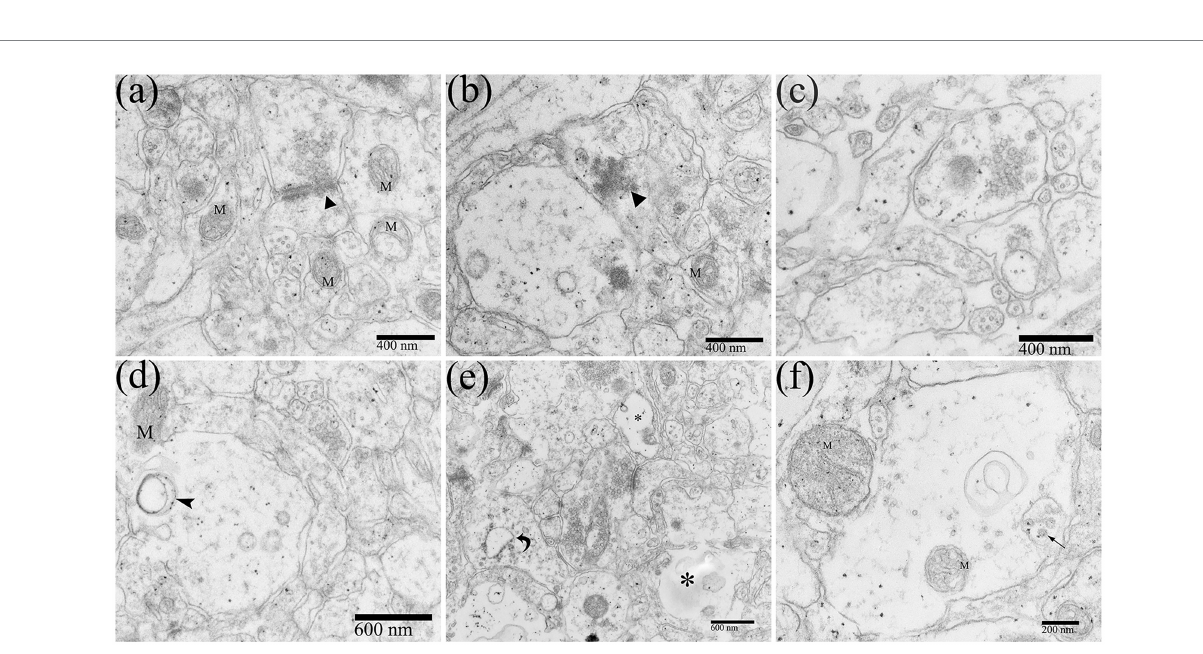
FIGURE 7 Ultrastructural pathological changes of the neuropil in the DTMUV-infected duckling brain. (A,B) Abnormal synapse structure (black triangle). (C) The gaps in the components of the neuropil were widened and evacuated. (D) The vacuole within dendrite. (E) The RER in dendrites was swollen (crooked arrow) and the contents were dissolved ( * ). (F) DTMUV virions in vesicle within dendrites. M,